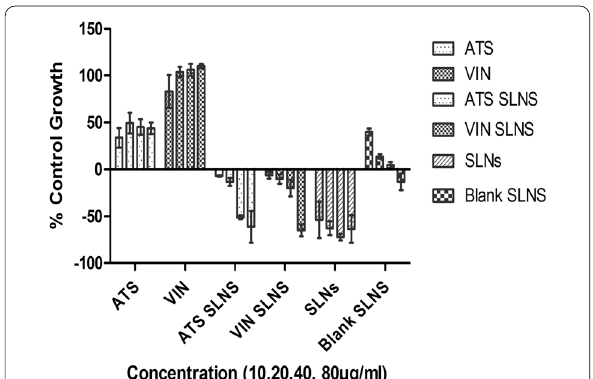
Fig. 7 Growth curve: human breast cancer MCF 7 cell line